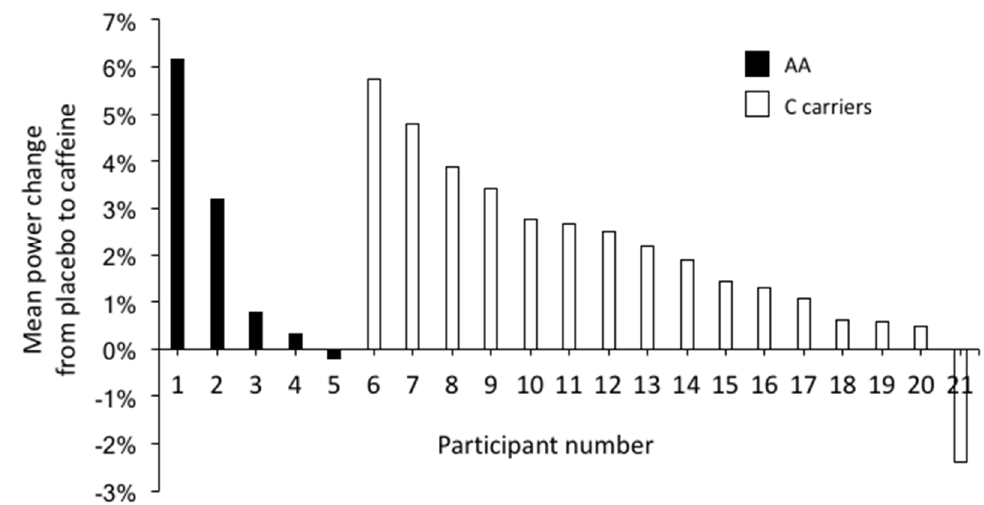
Figure 3. Individual responses during the Wingate test. Performance change from placebo condition to caffeine condition for AA homozygotes ( n = 5) and C-allele carriers ( n = 16).